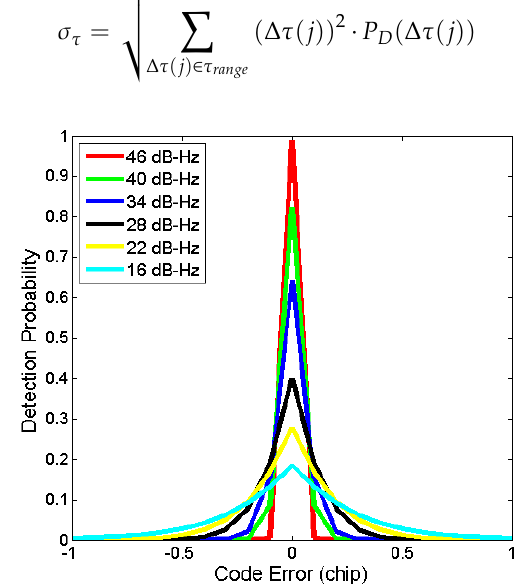
Figure 5. Code error of the open loop under thermal noise. •